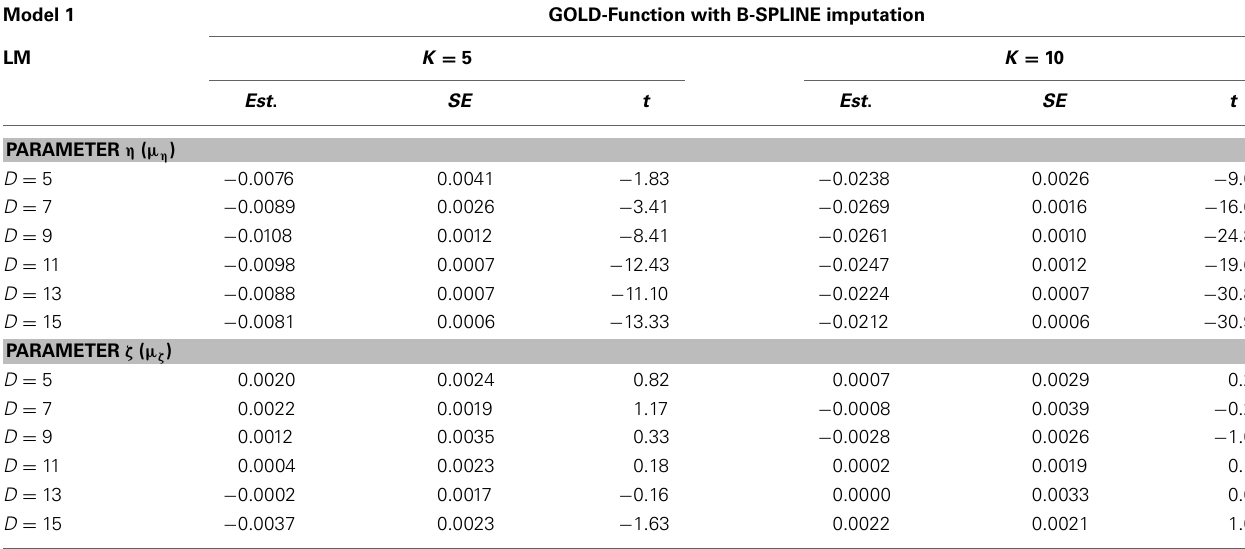
Table 1 | Estimated fixed effect of Parameter η using Model 1 applied on B-spline imputed data. Model 1